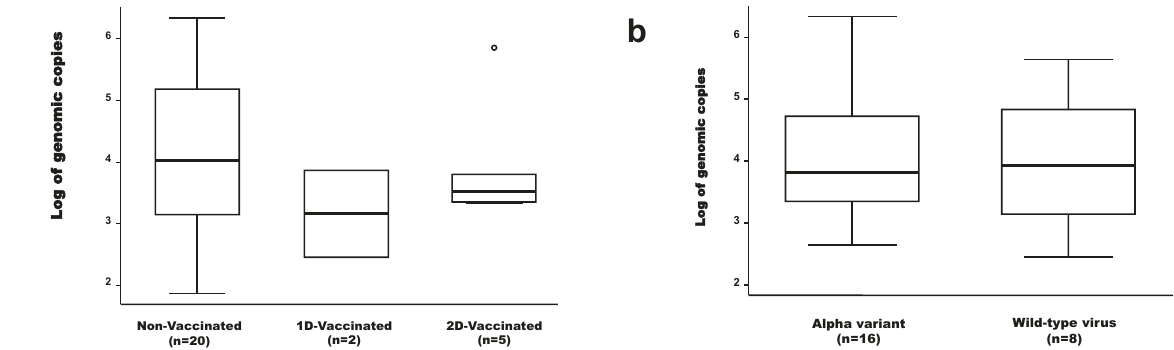
Fig. 6 Logarithm of the number of genomic copies estimated based on ORF1ab gene. a Non-vaccinated versus vaccinated groups. b Wild-type virus versus Alpha variant. Log, logarithm in base ten. The dashed line represents the median of the log of genome copies; the solid lines below and above each rectangle represent, respectively, the fi rst and the third quartiles; adjacent lines to the whiskers represent the limits of the 95% con fi dence interval; small circles represent outside